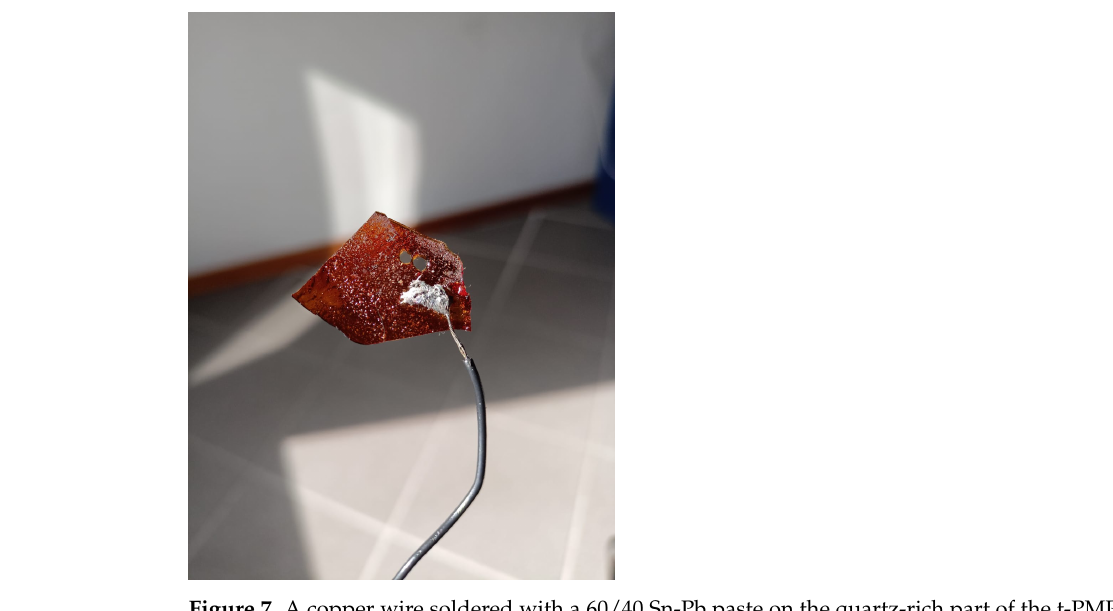
Figure 7. A copper wire soldered with a 60/40 Sn-Pb paste on the quartz-rich part of the